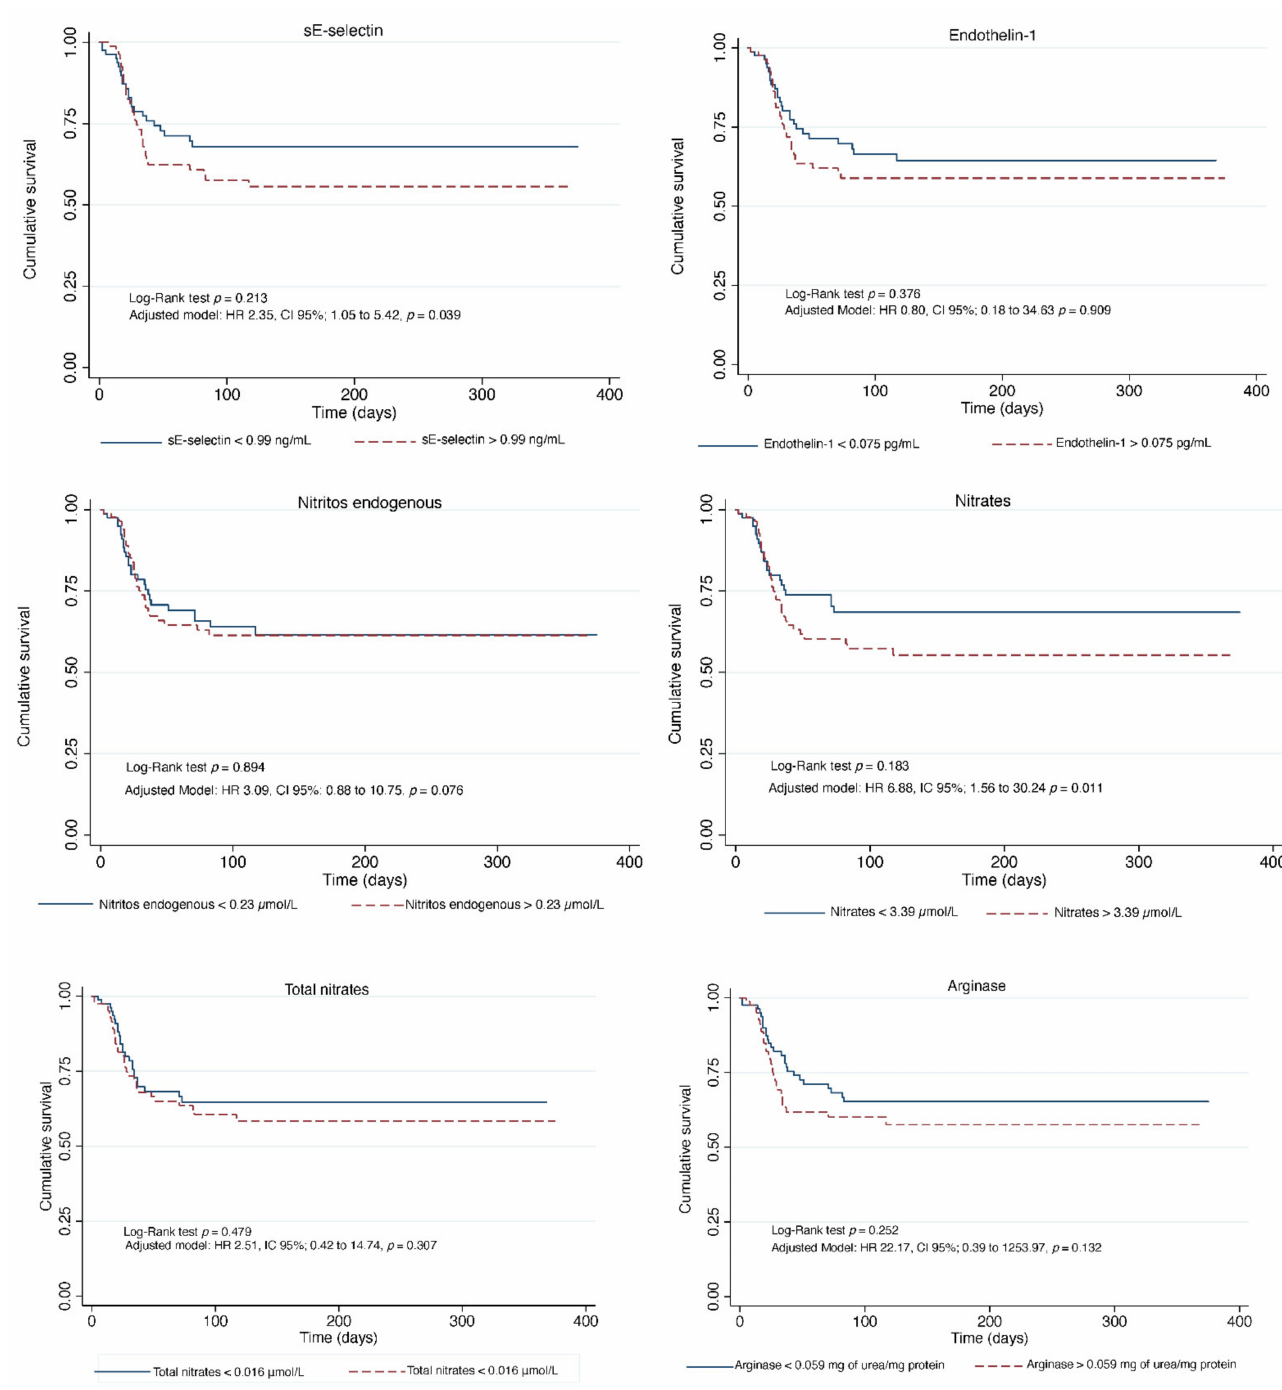
Figure 3. Kaplan-Meier curves for endothelial